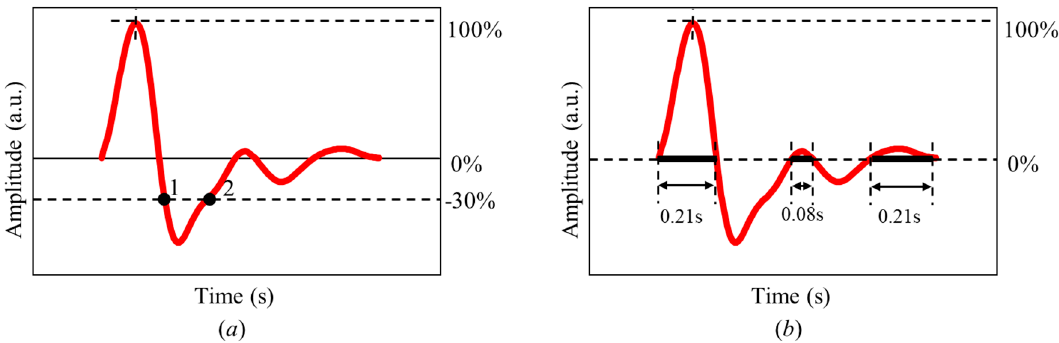
Figure 4. LCF extraction. ( a ) Number of crossings between a waveform and a contour line (LCF 1); in this figure, the number of filled circles on the − 30% contour line is two. ( b ) Total length of each contour line lying within the waveform (LCF 2); in this figure, the length of the horizontal bold line on the 0% contour line is 0.5.